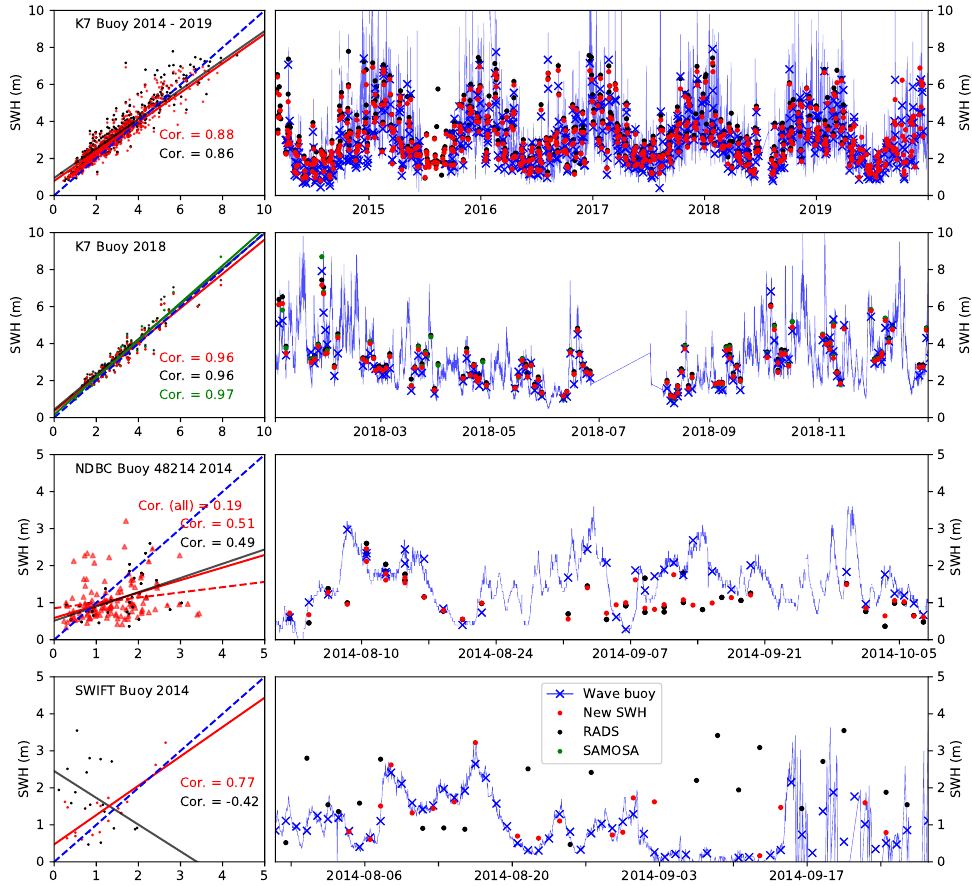
Figure 6. Comparison of our CS2 derived SWH and other satellite products. The top row is Met Office buoy K7 2014 to 2016 and our SWH and RADS data. The second row is a closer look at buoy K7 over 2018 with additional SAMOSA data. Row three is NDBC buoy 48,214 in 2014-(08 to 10). The bottom row is for the Swift floating wave-buoys deployed in the Beaufort sea in 2014-(08 to 09). The blue lines are the complete buoy wave height record, with crosses indicating the 6 hour mean value coinciding with a satellite record within 100 km of the buoy